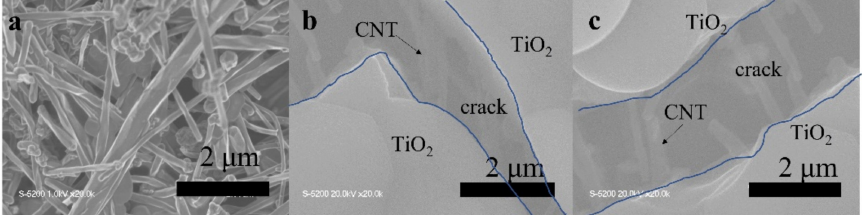
Figure 1. Scanning electron microscopy (SEM) images of: ( a ) CNTs and ( b ) and ( c ) prepared T-C film containing cracks.